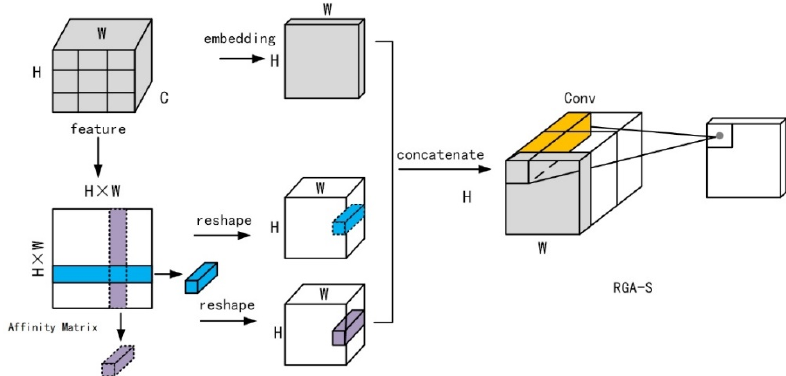
Figure 10. RGA-S structure diagram.